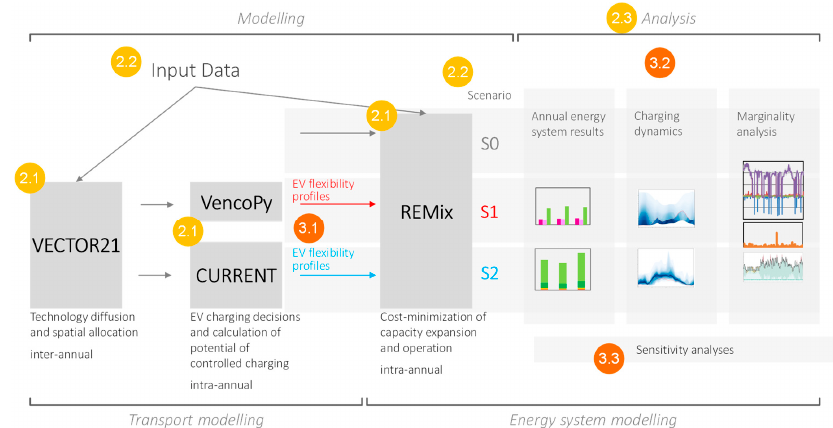
Figure 1. Overview of the four models used in the analysis (VECTOR21, VencoPy, CURRENT, and REMix), data flow, and paper structure. The numbers refer to the section of the paper where the item is discussed.